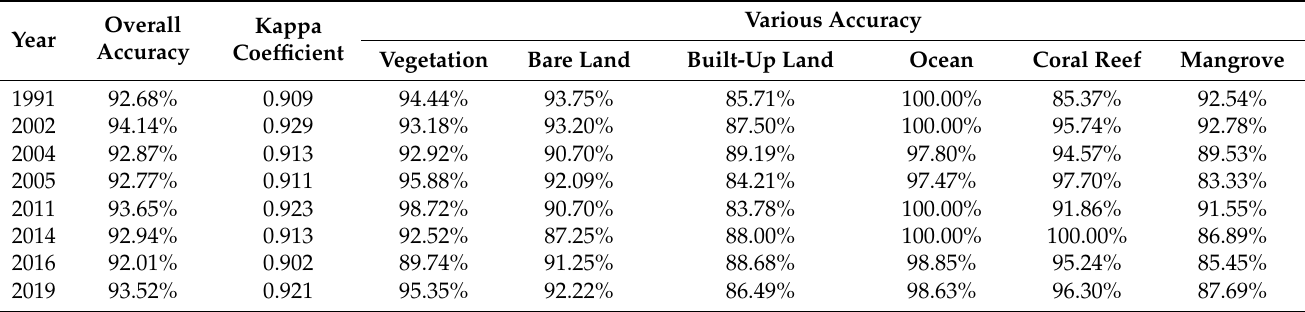
Table 2. Classification